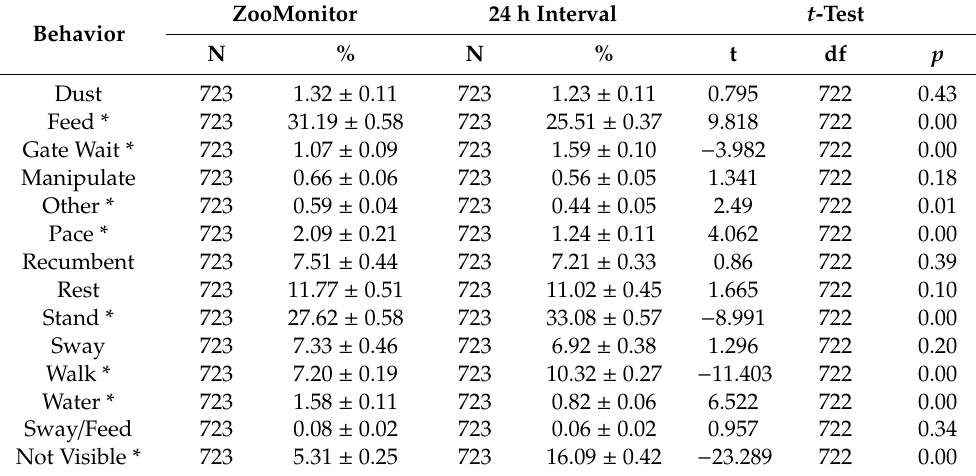
Table 3. Mean (% ± standard error) proportion of time elephants were observed exhibiting state behaviors through 30 min focal observations (ZooMonitor) versus 24 h interval closed circuit camera with camera trap sampling methods. Results were compared between methods using a paired sample t